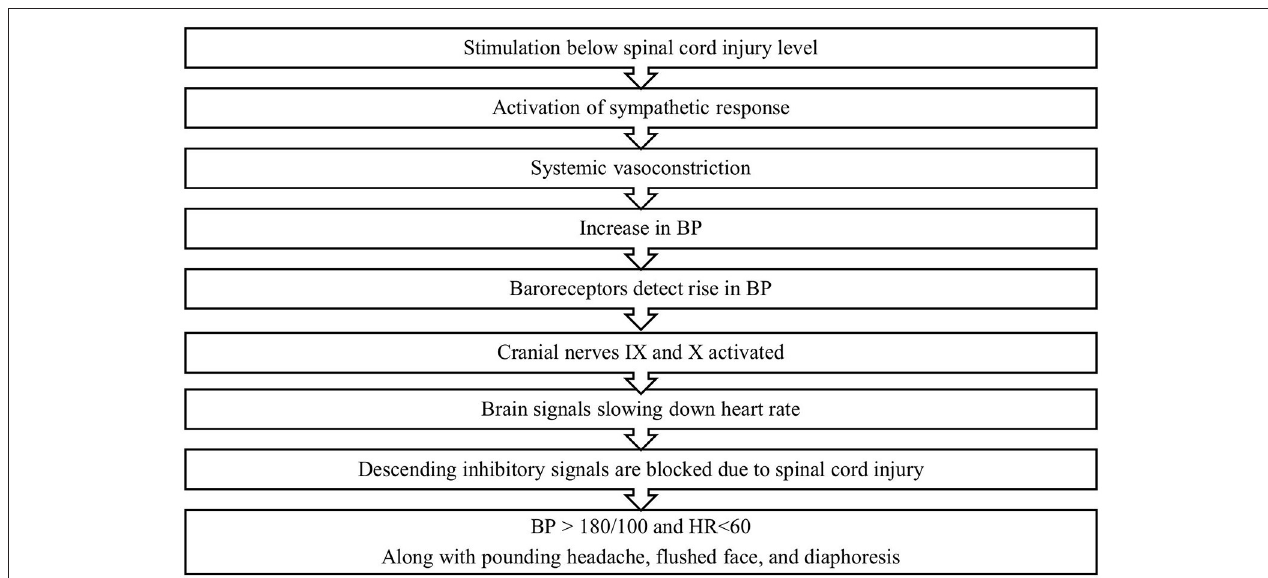
FIGURE 2 | Mechanisms of autonomic